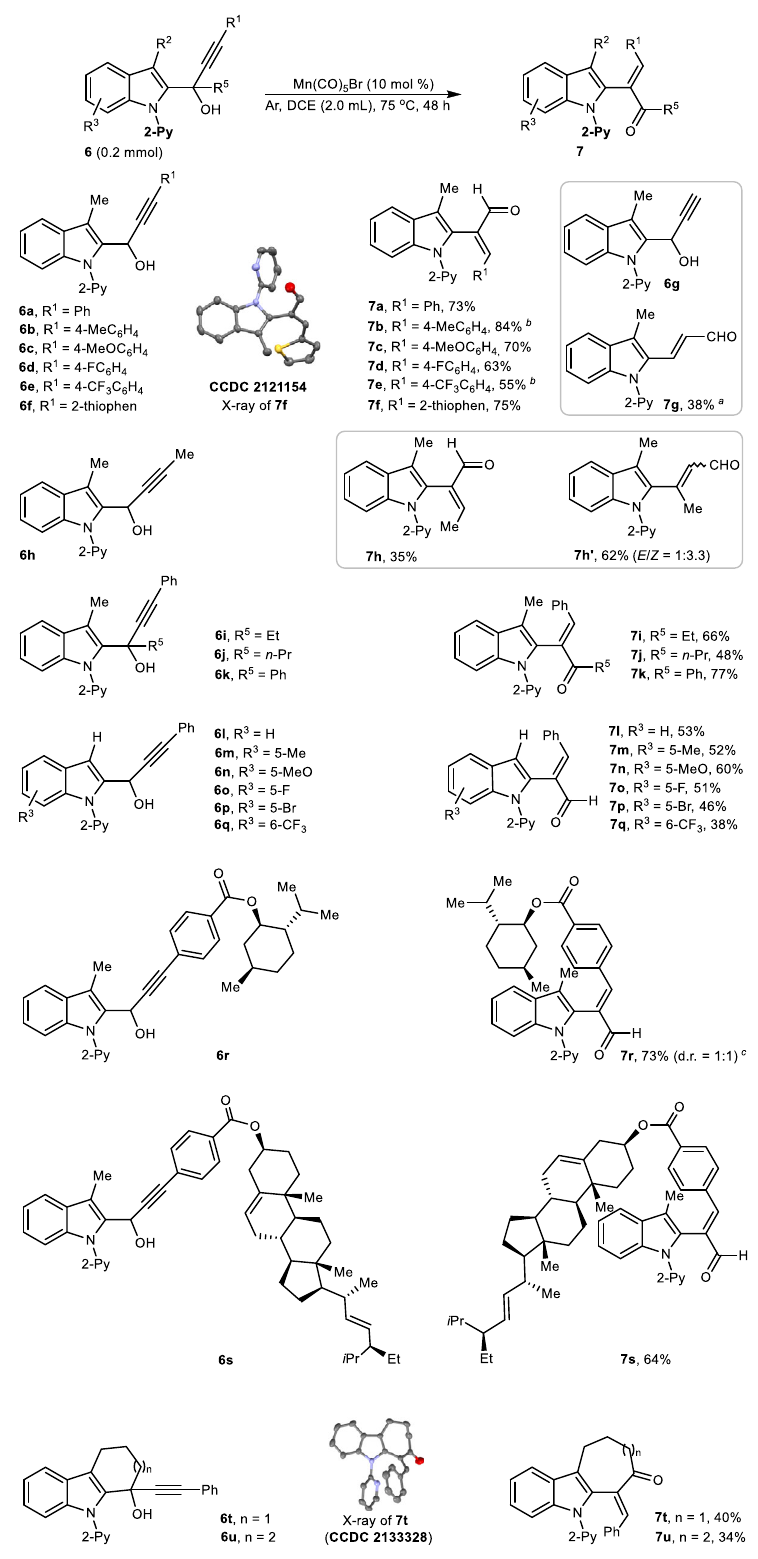
Fig. 4 | Propargylalcohol scope. Allwereperformed in a sealed tube, followed by fl ash chromatography on SiO 2 . The yields were determinedby isolation. a The reaction time is 24h. b The reaction time is 72h. c Diastereomeric ratio ( d.r .) was measured by 1 H NMR